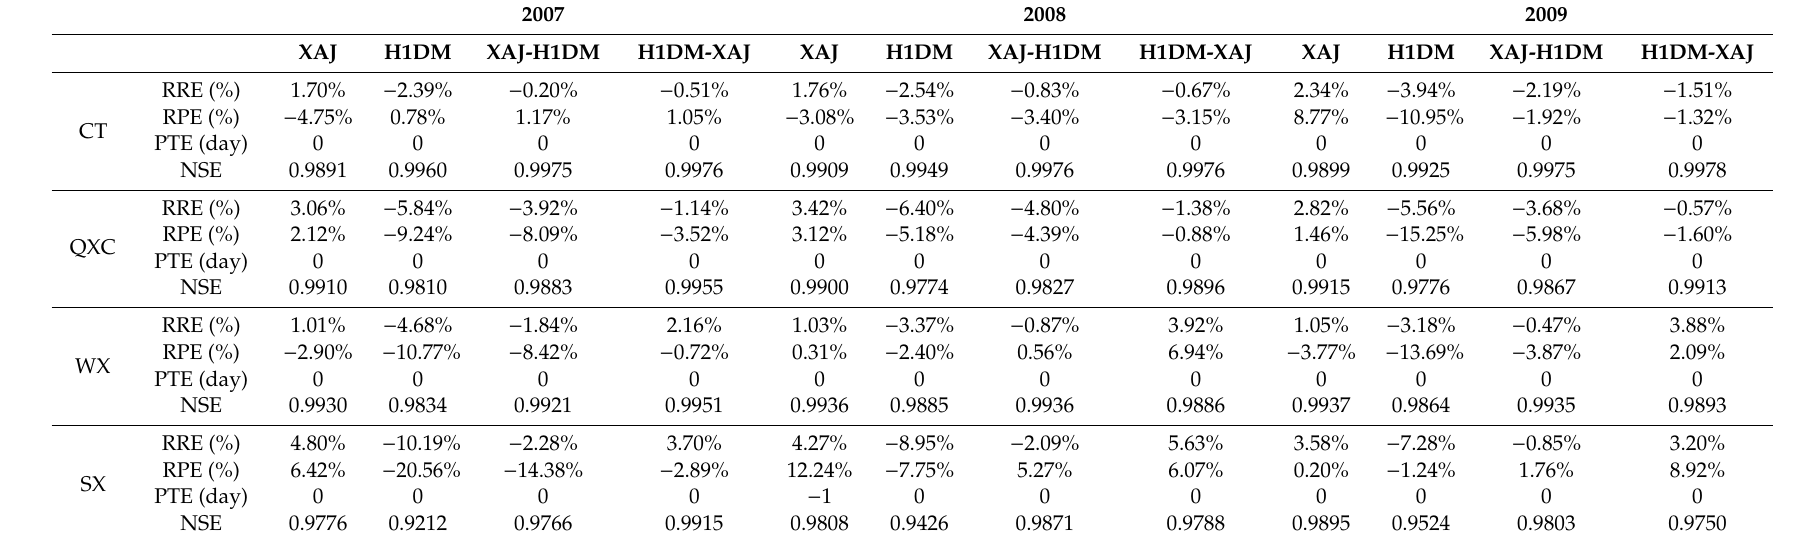
Table 3. Accuracy statistics of the four model flow simulations with calibrated parameters for both calibration and validations